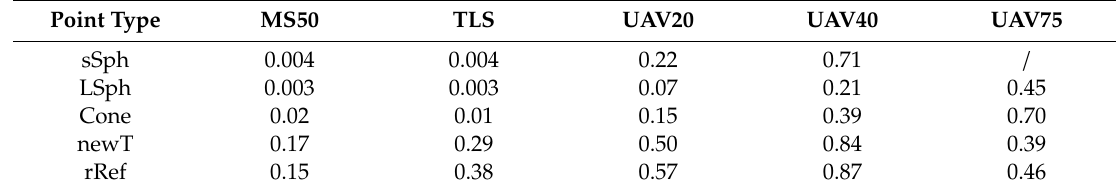
Table 4. Two-dimensional precision of coordinates of reference target points (in cm). sSph: Small